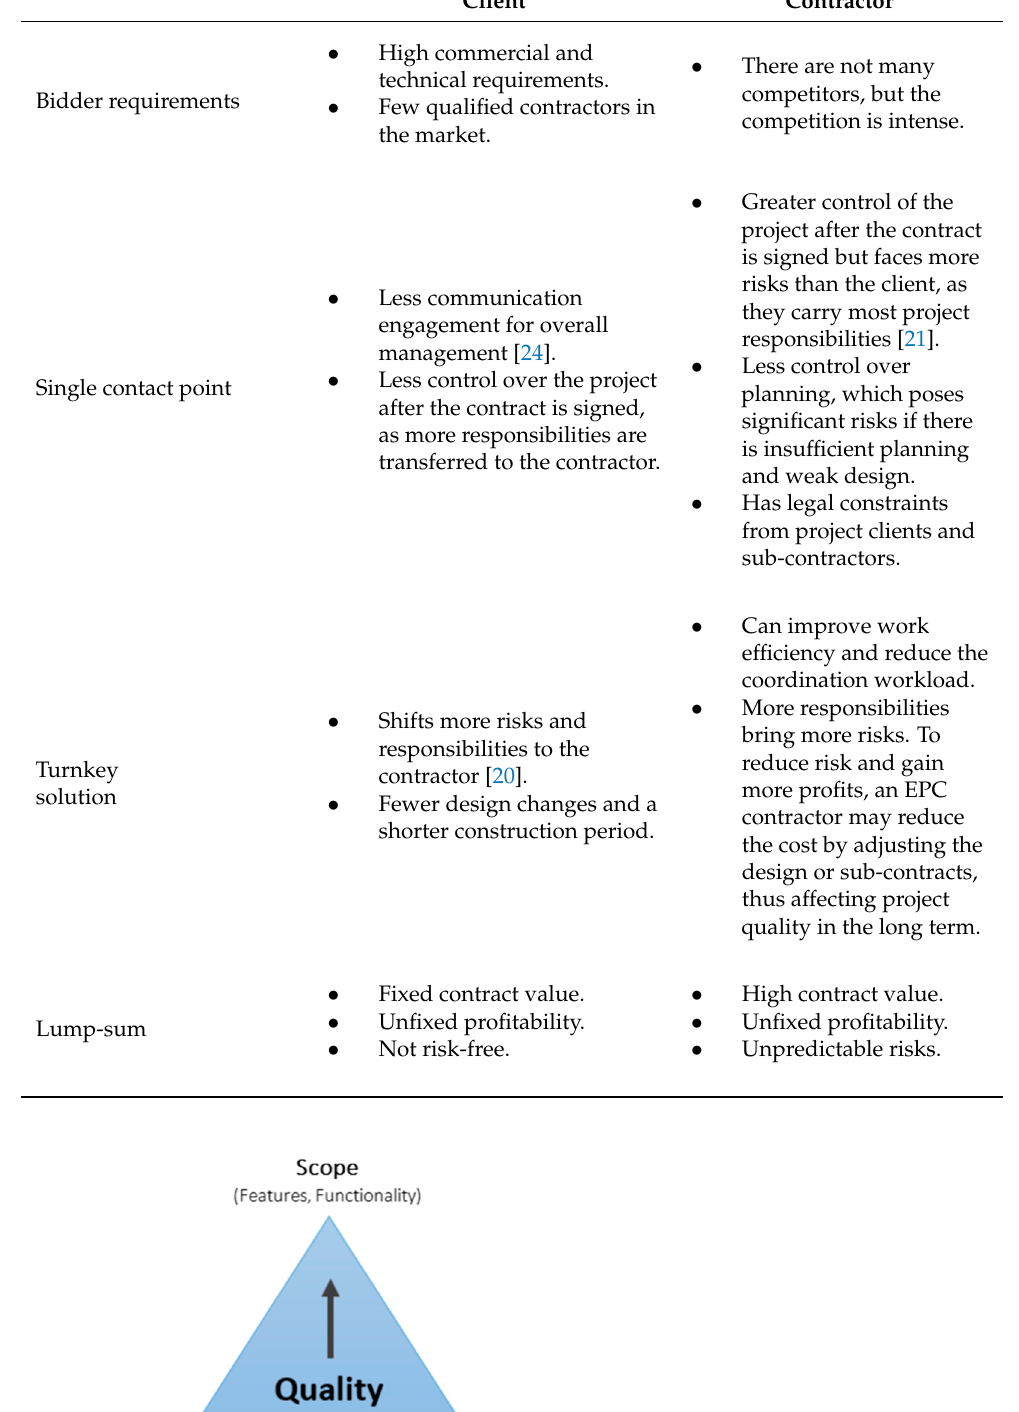
Table 1. EPC project model impact for client and contractor.